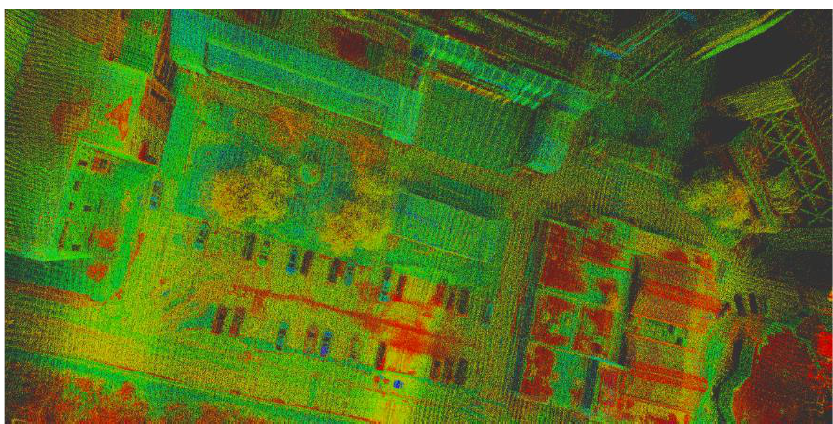
Figure 6. LiDAR SLAM trajectory generated using optimized LOAM SLAM algorithm [41].